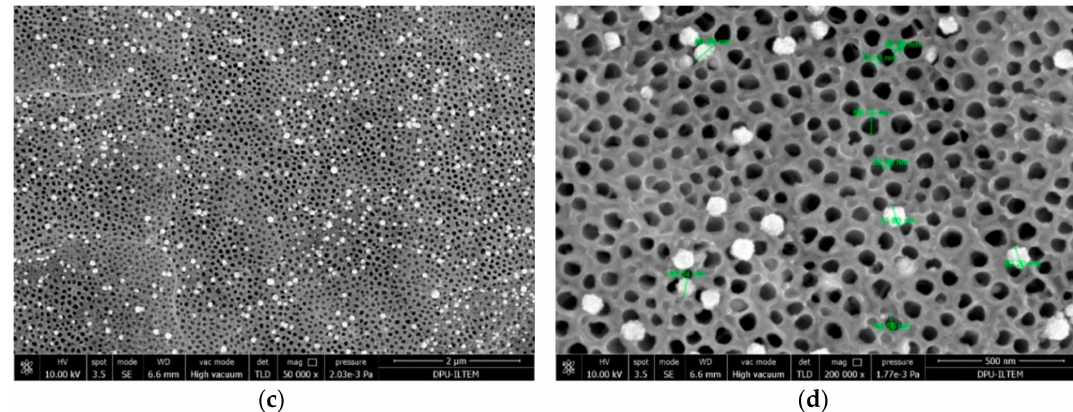
Figure 9. SEM images of photoanodes: Ti/TiO 2 NTEG-3h-500 ( a , b ); and Ti/TiO 2 NTEG-3h-500-Pt- 4cycles ( c , d ). Magnifications: 50,000 × ( a , c ); and 200,000 × ( b , d ).